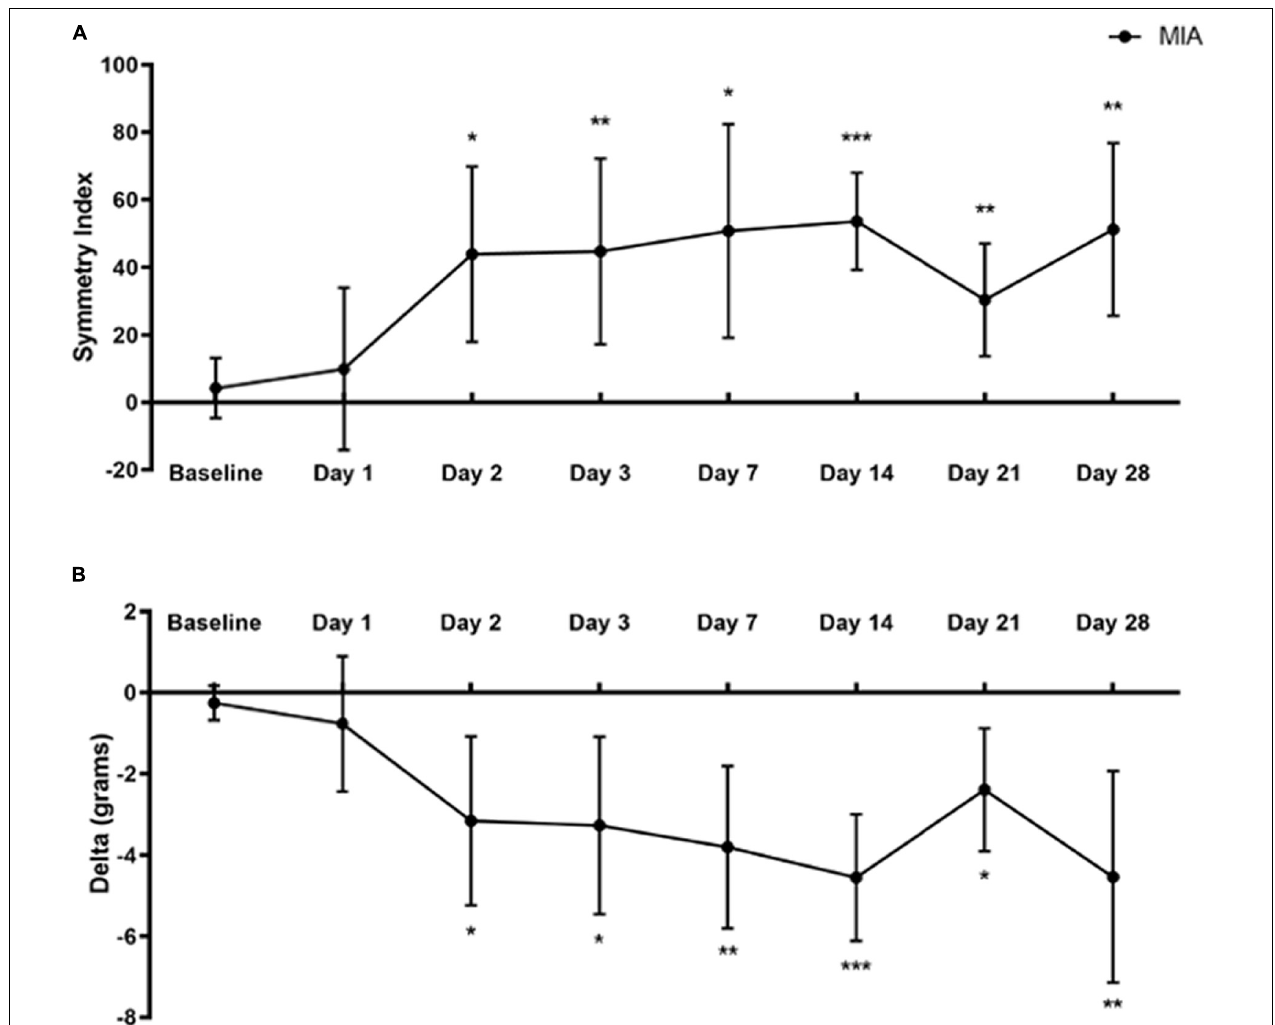
FIGURE 2 | Static weight-bearing after MIA induction. Standing body weight distribution on the hind limbs was measured over 28 days following intra-articular MIA injection in mice. Hind limb Symmetry Index (A) , and Delta, or the difference between the weight placed on the MIA-injected right and control left legs (B) was determined at baseline, 1, 2, 3, 7, 14, 21, and 28-days post-MIA injection. Mice displayed a greater degree of MIA-induced asymmetry and decreased weight-bearing on day 2 and onward, compared with the pre-injection baseline values. MIA ( n = 8). Data are represented as mean ± SD (* p < 0.05; ** p < 0.01; *** p < 0.001). A one-way ANOVA with repeated measures and Geisser–Greenhouse and Dunnett multiple corrections.